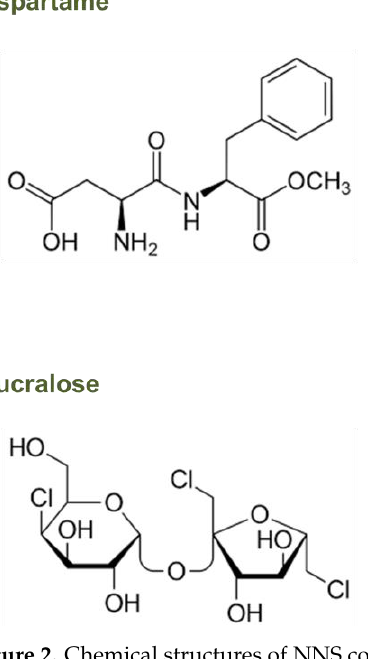
Figure 2. Chemical structures of NNS considered in this study. Acesulfame-K is a hydrophilic, organic acid derivative (Figure 2) that is absorbed almost entirely in the small intestine as an intact molecule and is distributed by the blood to different tissues. Without undergoing any metabolism, more than 99% of ingested acesulfame-K is excreted in the urinary tract within the first 24 h, with less than 1%